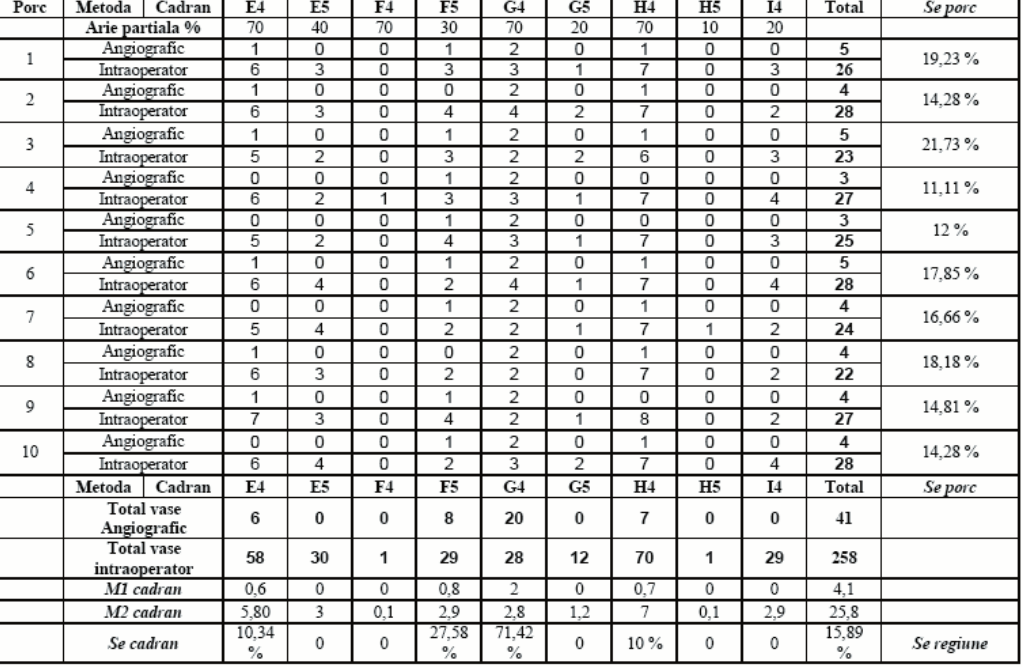
Also, were performed comprehensive maps showing the imagistic versus surgical averages.